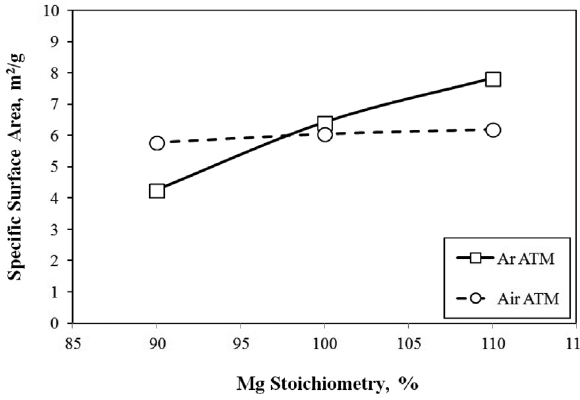
Fig. 6: Specific surface area results of leached SHS products synthesized under atmospheric conditions and argon atmosphere